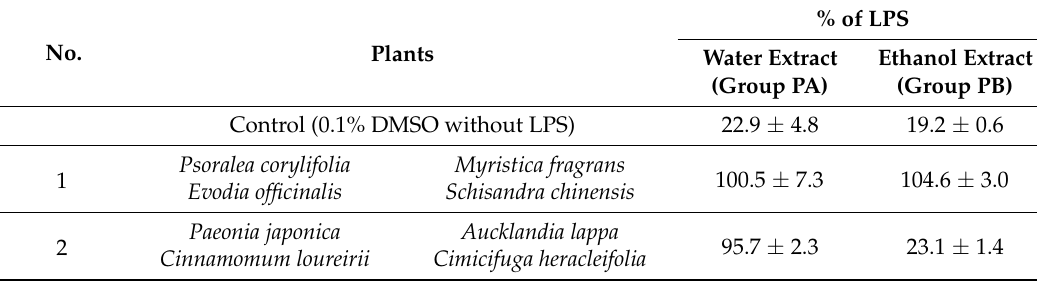
Table 3. NO assay results of prescription plant